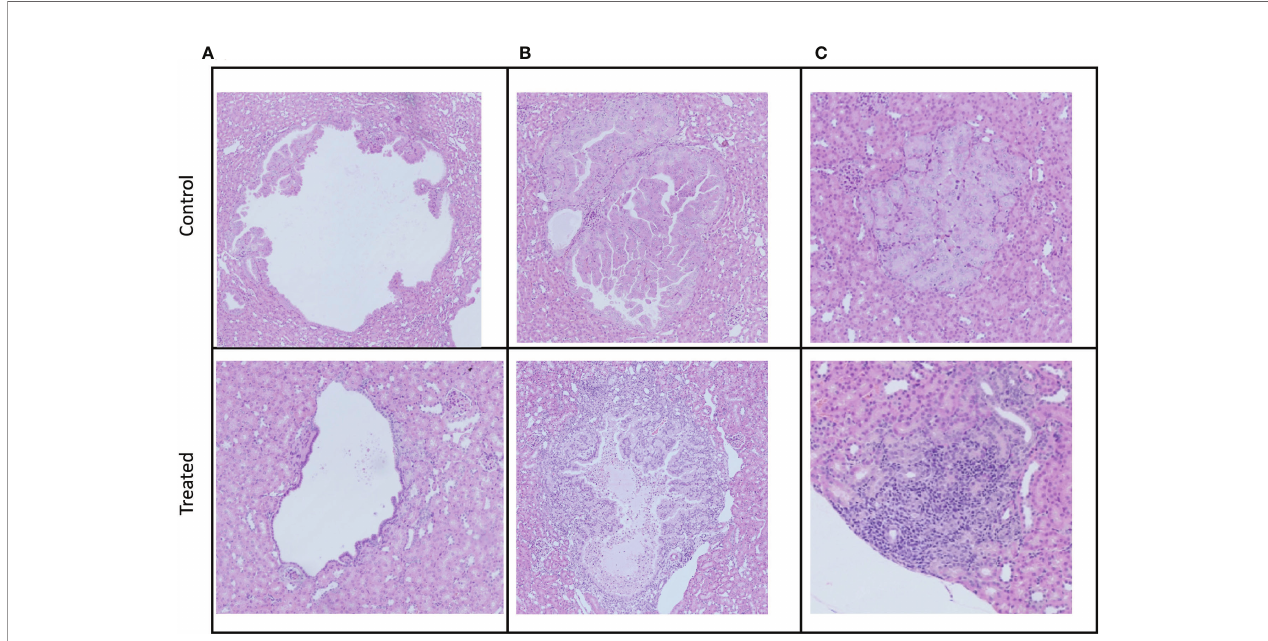
FIGURE 6 | Examples of the three different manifestations of kidney cystadenomas in control and treated mice. Tumors were harvested after week 3 imaging. All pictures were taken at a 10× magni fi cation. (A) Cystic lesions. (B) Papillary lesions. (C) Solid